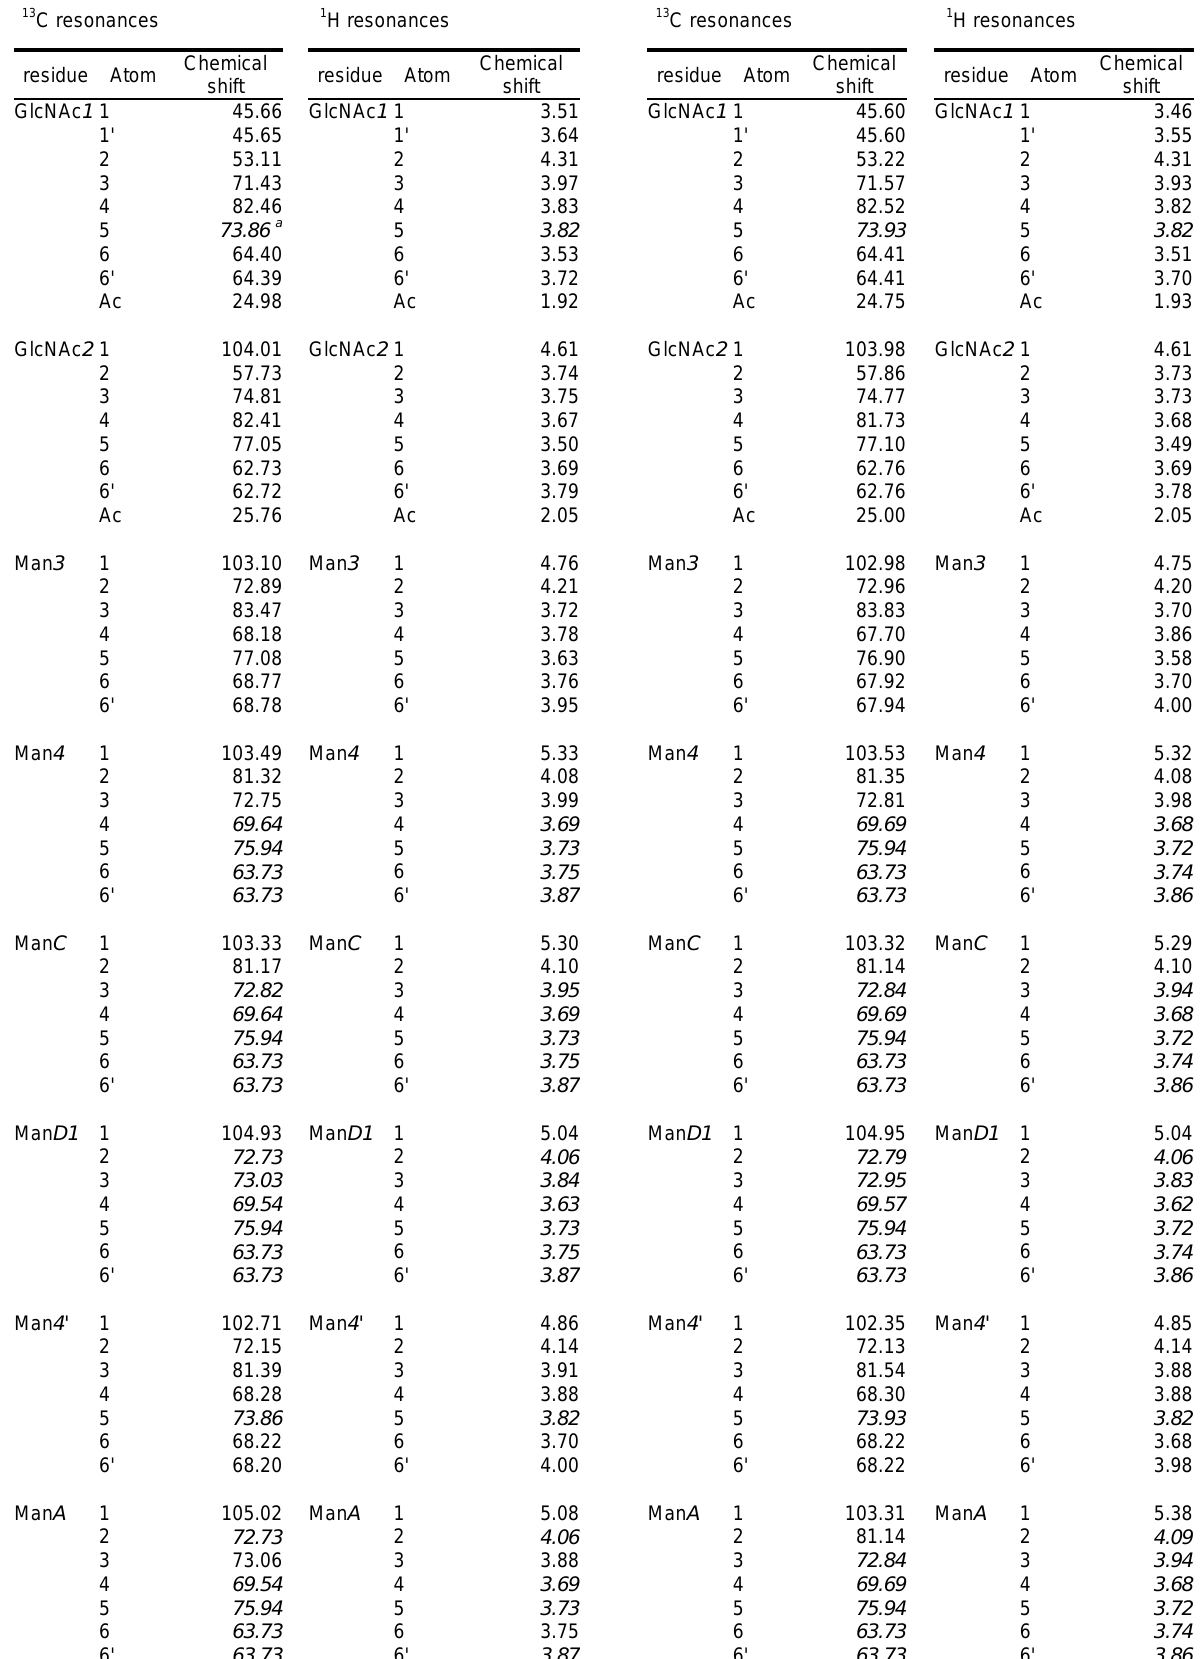
Table S1. Chemical shift values (ppm) of PA-M8B and PA-M9. 13 C resonances 1 H resonances 13 C